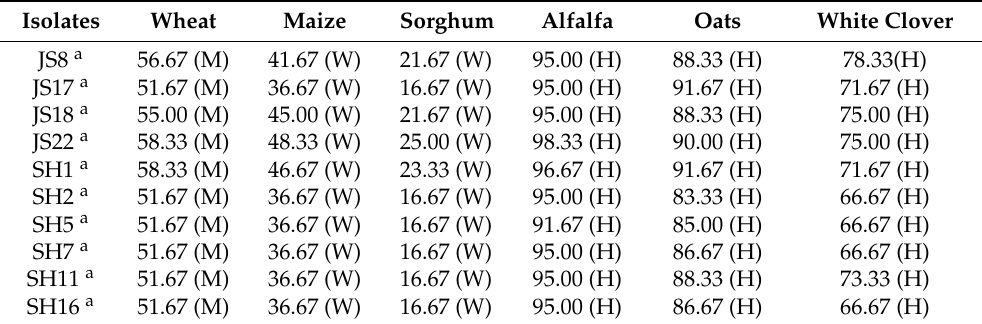
a Values in the column indicate the mean disease index of rice seedling blight caused by ten Pythium aristosporum isolates. Capital letters in brackets in the column indicate pathogenicity to different crop seedlings (soybeans, black soybeans, and cucumbers were also inoculated, but no symptoms were recorded).